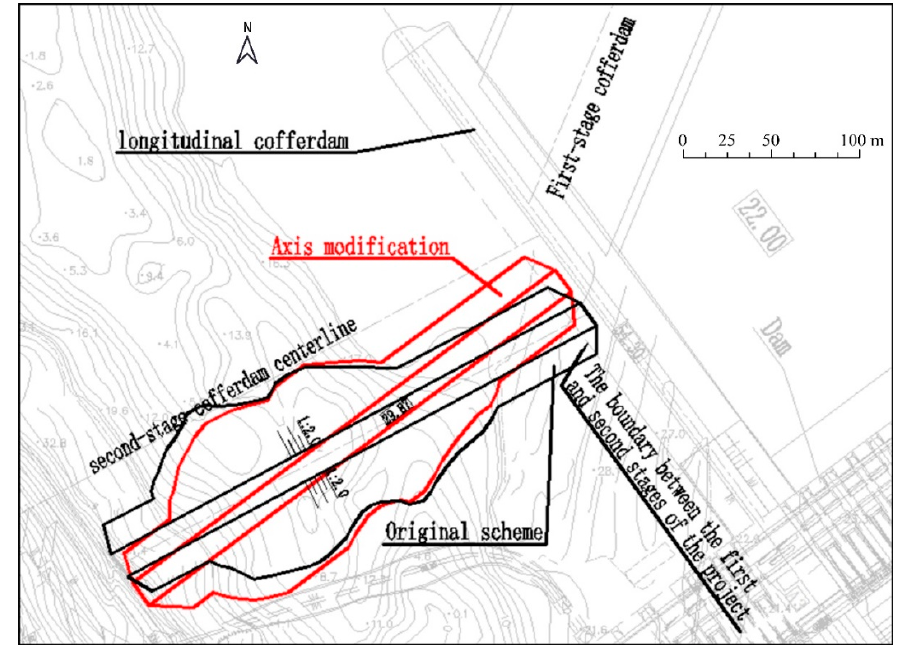
Figure 11. Layout of the berm.